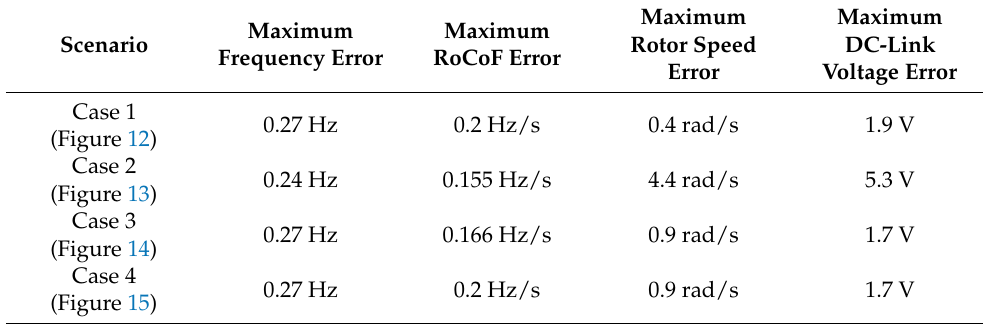
Table 2. Error analysis for the simulation